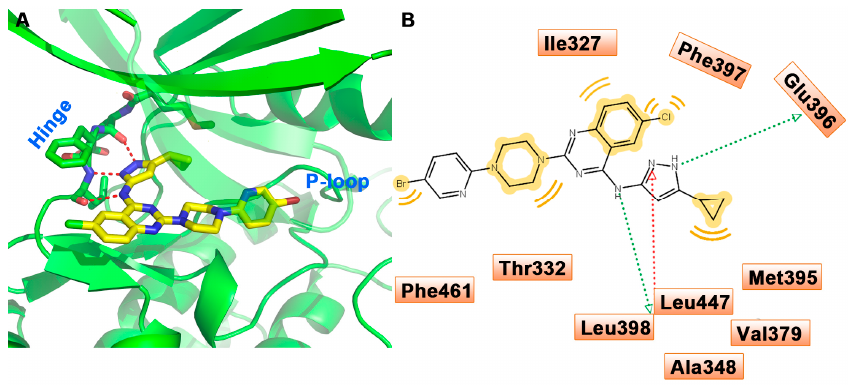
Figure 3. Model of compound 8d bound to PAK4, generated by energy minimization of the elaborated structure of 8d within the PAK4 protein using the MMFF94 force field within LigandScout. ( A ) Detailed interactions with the protein residues. Hydrogen bonds are rendered as dotted red lines; ( B ) 2D interaction diagram showing compound 8d docking pose interactions with the key amino acids in the PAK4 active site by LigandScout.